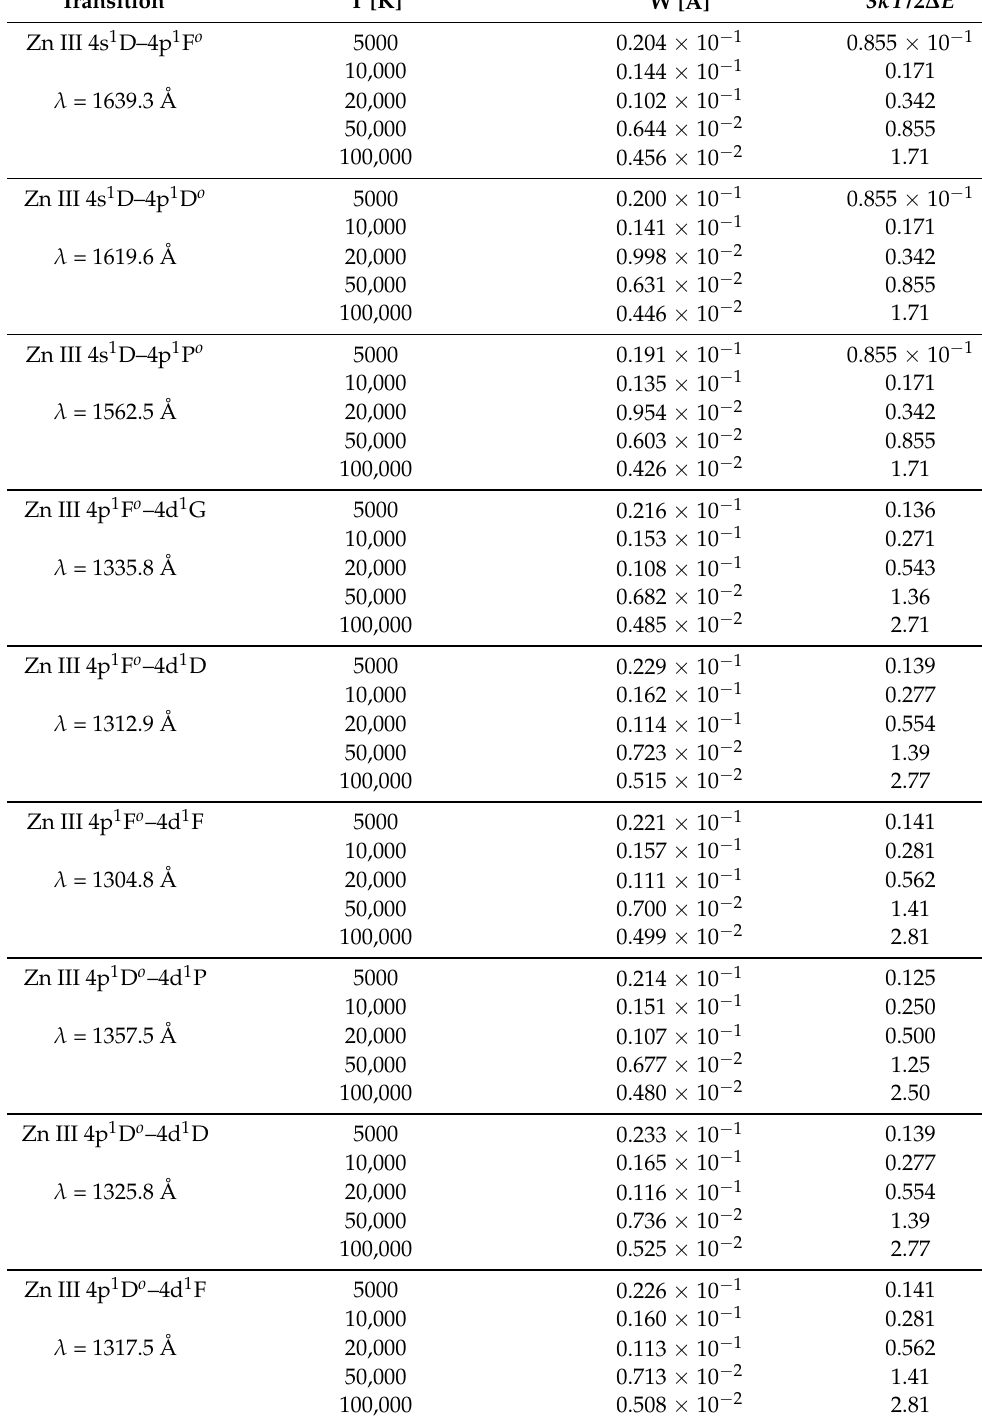
Table 1. This table gives electron-impact broadening (Stark broadening) Full Widths at Half Intensity Maximum (W) for Zn III multiplets, for an electron density of 10 17 cm − 3 and temperatures from 5000 to 100,000 K. Also, the 3 kT /2 ∆ E , quantity is given, where ∆ E is the energy difference between closest perturbing level and the closer of initial and final levels. This quantity shows the type of collisions contributing to line broadening. If this quantity is lower than one, collisions are elastic. Starting with the value of one, with its increase increases the influence of inelastic